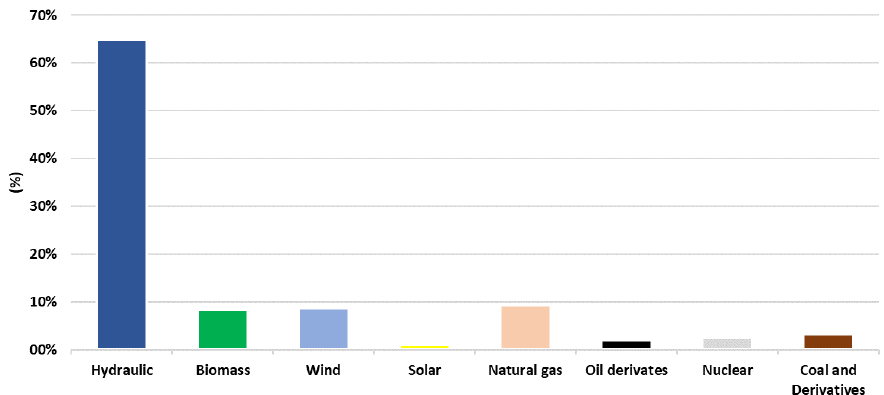
Figure 1. Electricity generation sources in Brazil, base year 2019. Reproduced from [1], Energy research company: 2020.